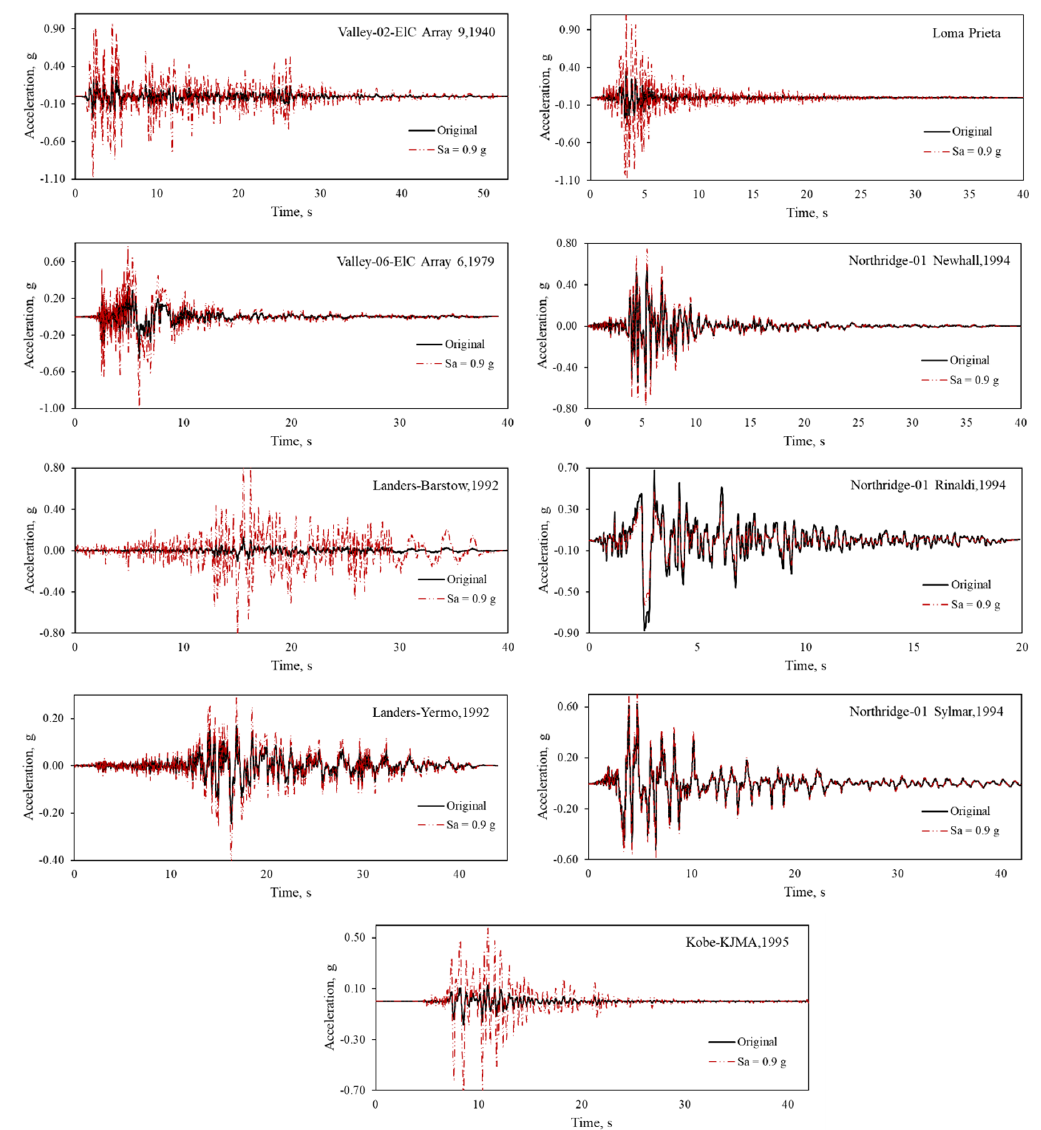
Figure 7. Original and scaled ground motions.